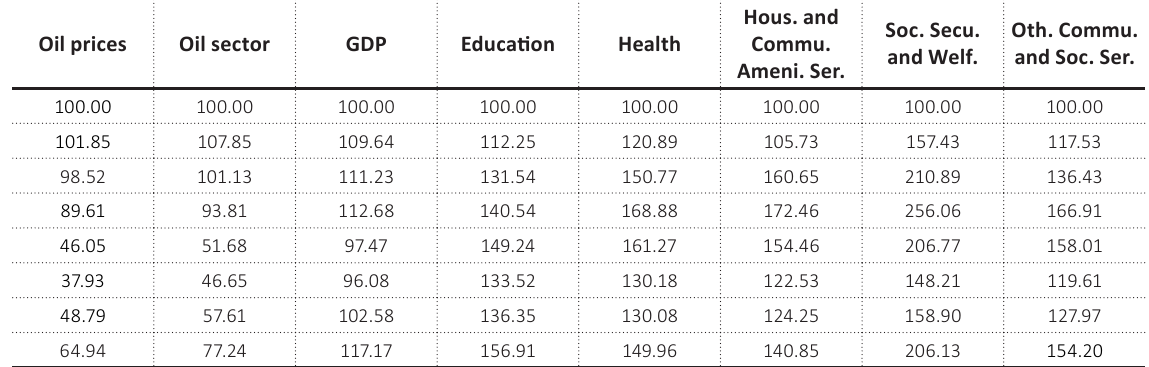
Table A2. CBI of oil prices, oil sector revenue, GDP, and public spending Oil